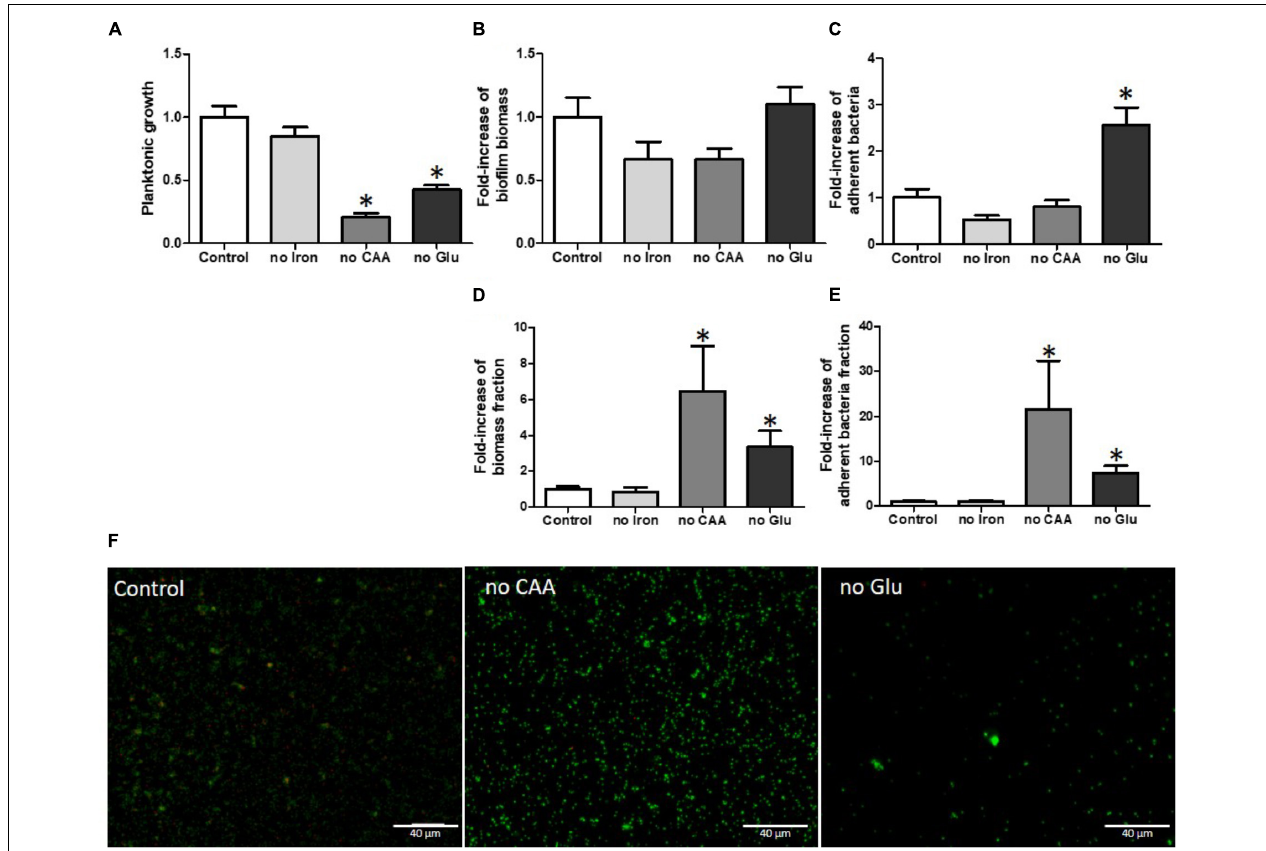
FIGURE 4 | Glucose and amino acid starvation increased S. aureus biofilm formation when normalized on planktonic growth. Planktonic growth normalized on control (A) fold-increase of biofilm biomass quantified by crystal violet staining (B) and fold-increase of live adhered cells (C) , fold-increase of biomass fraction on planktonic growth (D) and fold-increase of adherent cells fraction on planktonic growth (E) . Fluorescence microscopy (F) with live (green color)/dead (red color) staining. Scale bar = 40 µ m. no iron, without iron; no CAA, without casamino acids; no Glu, without glucose. ( n = 9). ∗ Statistically significantly different from control ( p < 0.05).